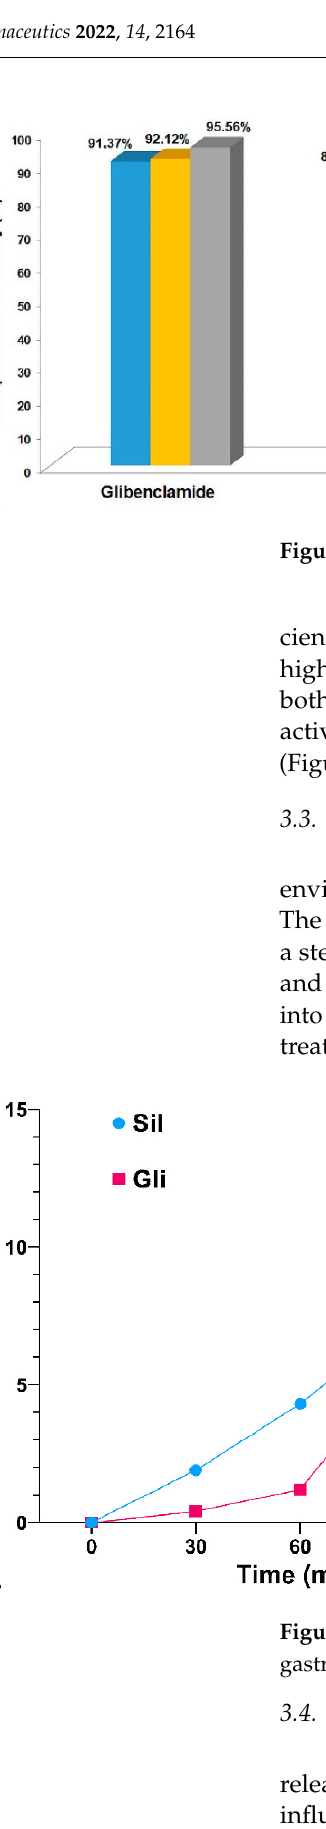
8 of 21 Figure 1. ESEM imaging: ( A ) CS microparticle; ( B ) CS-Gli-Sil microparticle. 3.2. Encapsulation Efficiency (EE%) and Drug Loading Percentage (DL%)